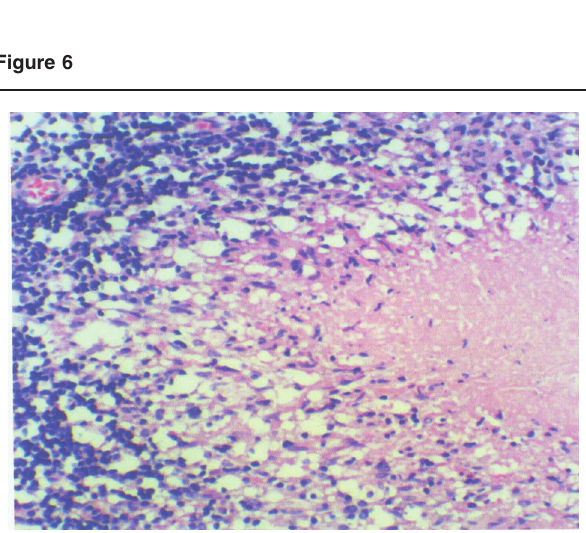
Showed longerhans giant cell and many lymphocytes with central necrosis.